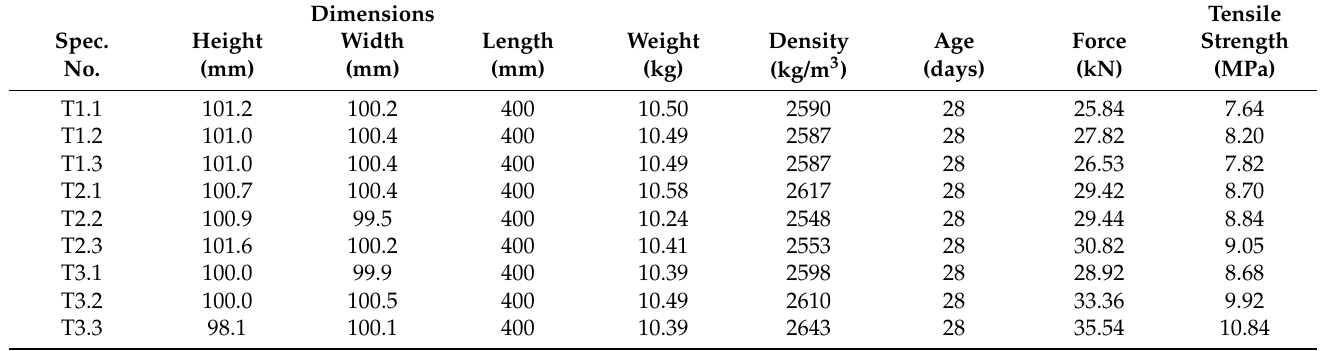
Table 3. Flexural test results of UHPFRC on samples of batches T1.1–T1.3, T2.1–T2.3 and T3.1–T3.